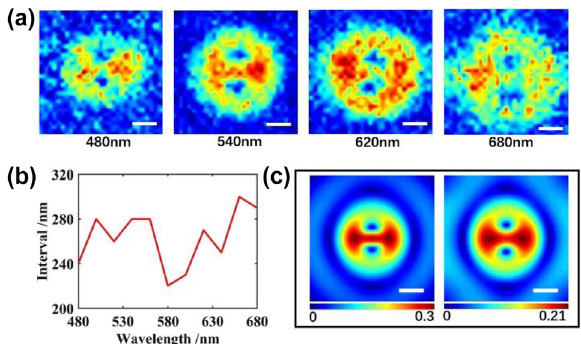
Figure 5: Influence caused by the change of wavelength and the diffraction. (a) Sin 𝛿 image of split-ring under 480 nm, 540 nm, 620 nm and 680 nm wavelength, (b) interval between two singularity points under different wavelengths, (c) simulated sin 𝛿 before and after diffraction. Scale bar: 200